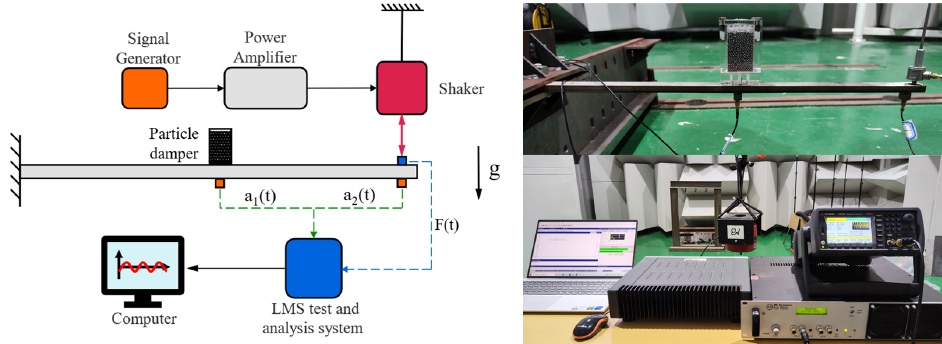
Figure 2. Schematic diagram ( left ) and picture( right ) of the testbed.